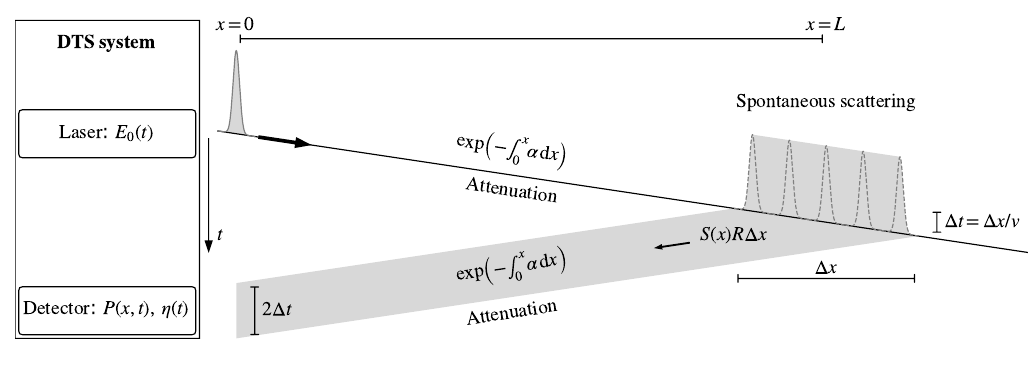
Figure 1. Path of a laser